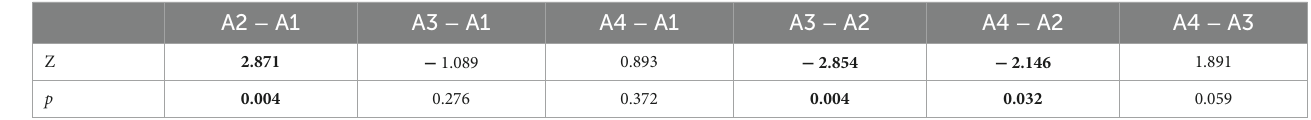
TABLE 4 Wilcoxon ranked sign test for the fixation duration when the target icon is linear type.